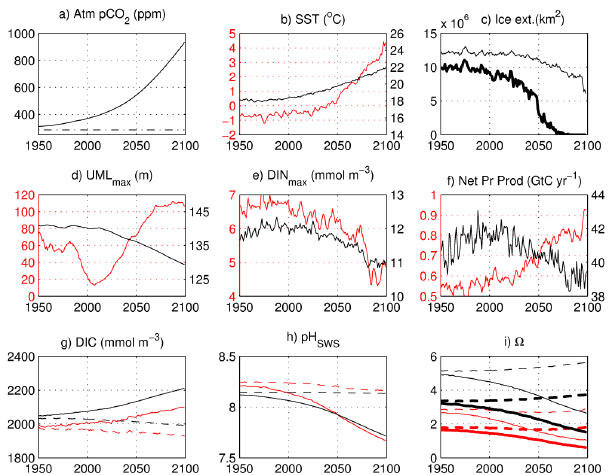
Fig. 1. Time evolution of modelled characteristics for the global ocean (black line and font) and the Arctic Ocean (treated as north of 66 ◦ N, red line and font): (a) atmospheric CO 2 (ppm) from the forcing Earth system model; (b) sea surface temperature ( ◦ C); (c) extent of the Northern Hemisphere sea ice (km 2 ) for September (thick line) and March (thin line); (d) maximum depth of the up- per mixed layer UML, (m); (e) annual maximum surface dissolved inorganic nitrogen (DIN, mmolm − 3 ); (f) water-column-integrated net primary production (gCyr − 1 ); (g) surface DIC (mmolm − 3 ); (h) pH SWS ; (i) (cid:127) c and (cid:127) a . Annual mean characteristics are given for all properties unless otherwise specified. For (g–i) dashed lines refer to the “climate-effect” run (no CO 2 increase); for (i) thin line refers to (cid:127) c , thick line refers to (cid:127) a .